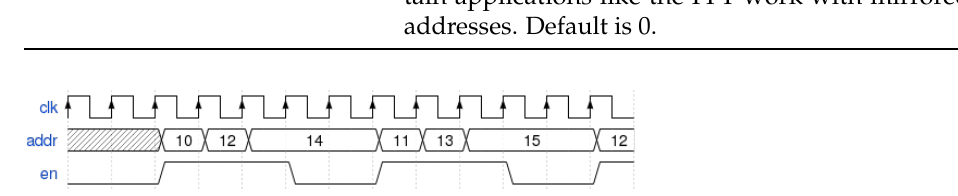
Figure 6. AGU output for Delay = 2, Per = 5, Duty = 3, Start = 10, Incr = 2, and Shift = −